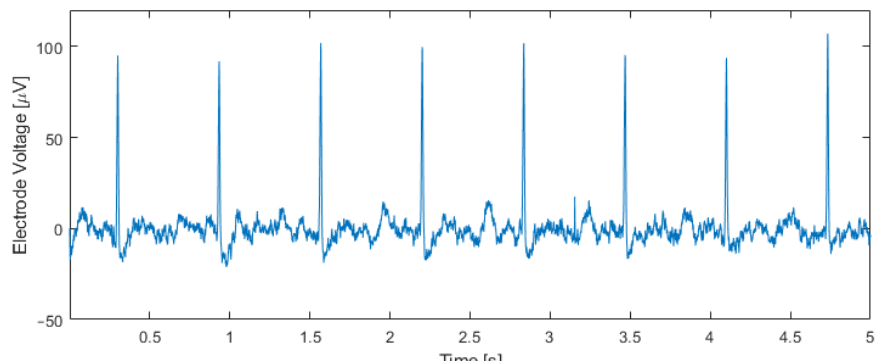
Figure 11. Measurement results using human IPSC-derived cardiomyocytes. The output bitstream of the modulator (C 0 = 4.25 pF) was band-pass filtered between 5 Hz and 200 Hz, unveiling cardiac potentials and a beating rate of 95 beats per minute, which matches the beating rate measured optically.